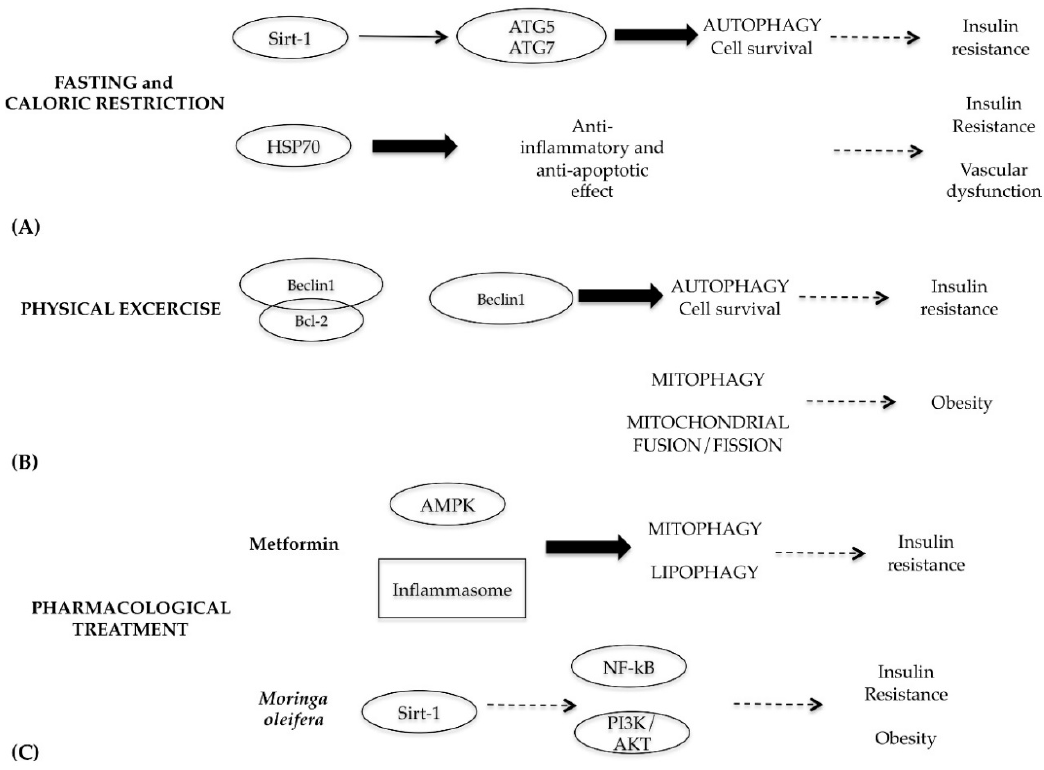
Figure 8. Schematic representation of autophagy modulation by fasting and caloric restriction, physical exercise or pharmacological treatment. ( A ) Fasting and caloric restriction acts on Sirt-1 and HSP70 proteins with autophagic and anti-apoptotic effect, respectively; ( B ) Physical exercise induces autophagy, disrupting the Beclin1 and Bcl-2 complex and balancing mitochondrial fusion/fission; ( C ) Treatments with Metformin or natural extract by Moringa oleifera restore mitophagy and lipophagy.